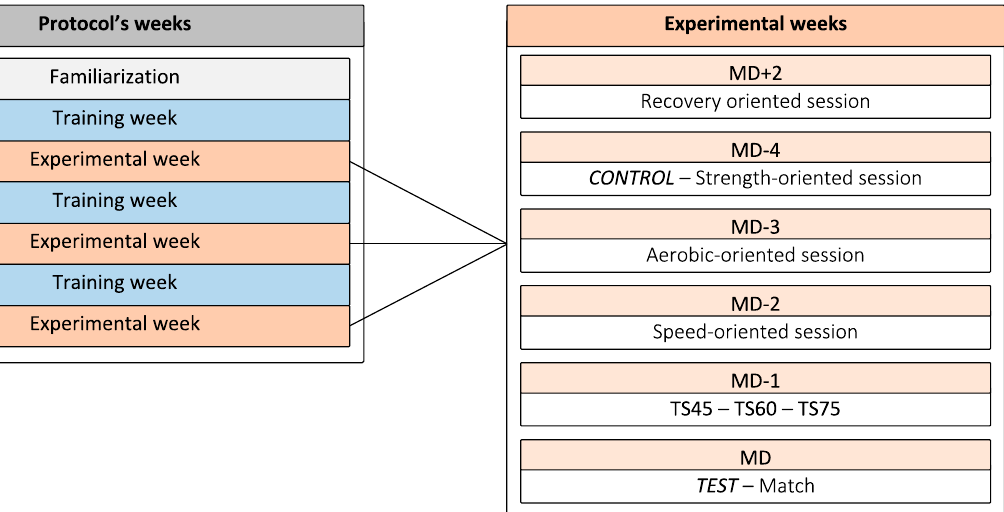
Figure 1. Study flowchart. Training weeks (identical contents) were performed to standardize the fitness level during the following experimental weeks. MD: Matchday; TS45: 45 min training session; TS60: 60 min training session; TS75: 75 min training session.